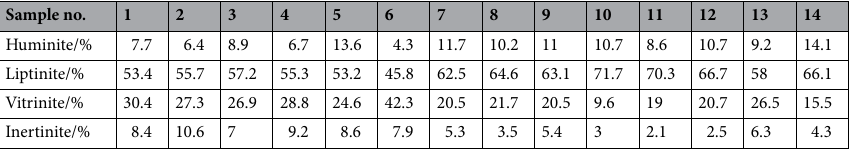
Table 1. Kerogen maceral